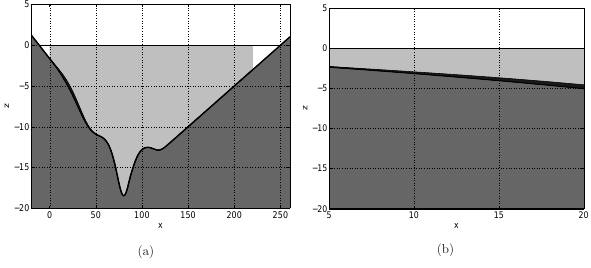
Fig. 11. The physical setup of the problem. The riverbed is indi- Figure 11. The physical setup of the problem. The river bed is indicated in dark grey. The computational fluid domain is shaded light grey, and the cated in dark grey. The computational fluid domain is shaded light landslide is visible in black. Note the difference in horizontal and grey, and the landslide is visible in black. Note the difference in hor- vertical scales in the left panel. The right panel shows a closeup of the left beach and part of the landslide in a one-to-one aspect ratio. izontal and vertical scales in the left panel. The upper panel shows a close-up of the left beach and part of the landslide in a one-to-one x = 40 and x = 60 show similar waveheights for both the shallow-water, and the dispersive system, but a qualitative divergence, as small oscillations are already developing which are aspect not captured by the shallow-water system. Once the waves have propagated to the wave gauges located at x = 80, the dispersive oscillations have amplified, so that the waveheight is larger by a factor of 2 to 3 than the waveheight predicted by the shallow-water system. Going further to the wave gauges located at x = 100 and x = 120, the now rising bottom starts to have a damping effect on the waves. The maximum and minimum free surface elevation over the whole domain is shown in Figure 13. On the lower panel of the same Figure 13 we show the maximal unsigned horizontal velocity. One can see that for short times the hydrostatic and dispersive models giveverycloseextremevalues. Laterthedifferencesstarttoappearduetotheaccumulation of dispersive effects. Figure 14 shows the development of the kinetic energy of the landslide mass and simulta- neously the total (kinetic plus potential) energy contained in the body of the fluid and the surface waves. Energy development is an important question in the study of tsunamis, and there have been studies exclusively devoted to this question [60]. Energy issues connected to water wave models of Boussinesq type have also been studied before [1, 2, 20]. While these models contained a source of energy, in the case at hand, the work done by friction as the landslide slides down the bottom acts as a drain of energy, and after the landslide has come to rest, all energy has been transferred to the fluid. However, not all energy can be considered as residing in the wave motion, because a significant amount of energy is needed to lift the water from the final position of the landslide to the initial position of